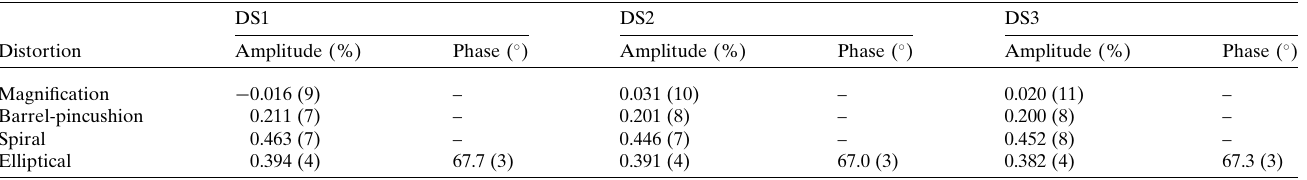
Table 2 Refined distortion parameters for datasets DS1, DS2 and DS3.